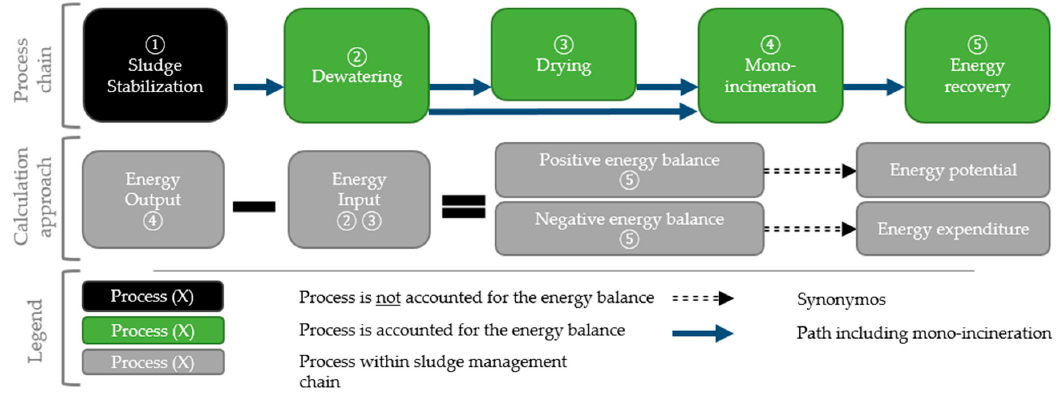
Figure 2. Overview to the processes accounted for and not accounted for the energy balance and respective basic calculation approach.